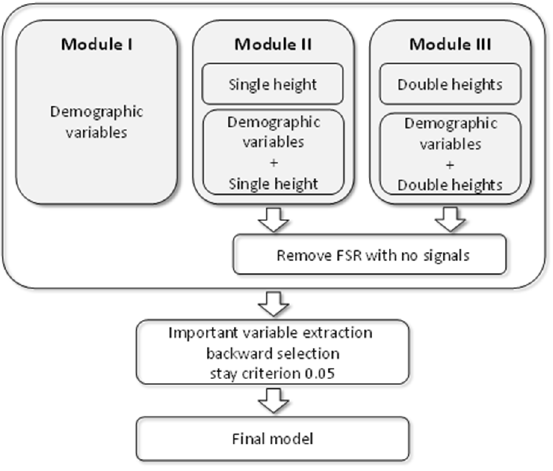
Figure 5. Flowchart for selecting final model for modules.